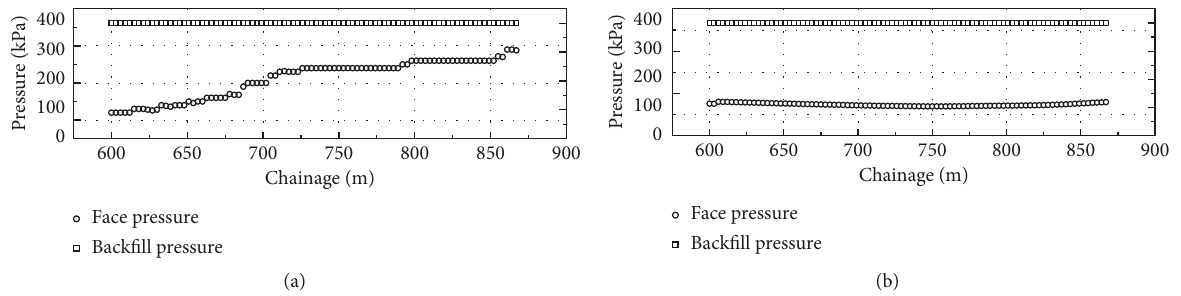
Figure 4: Face pressure and backfill pressure for tunnelling: down-track (a) and up-tack (b)